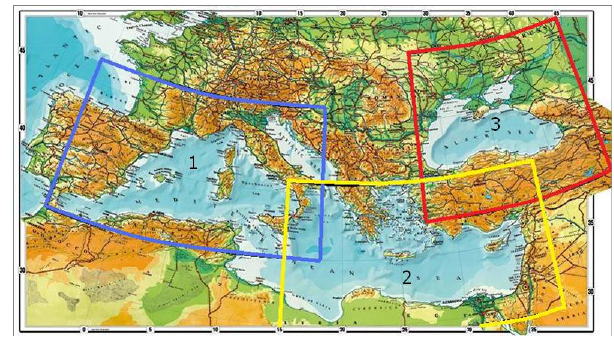
Figure 2. Boundaries of the studied regions: 1 – Western Mediterranean (35 – 47°N, 6 – 18°E), 2 3